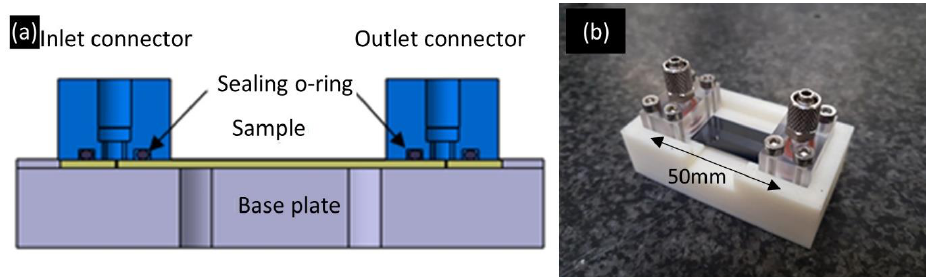
Figure 3. Schematic of the inlet and outlet connectors ( a ) and picture of the microcooling device assembled with the inlet and outlet system ( b ).